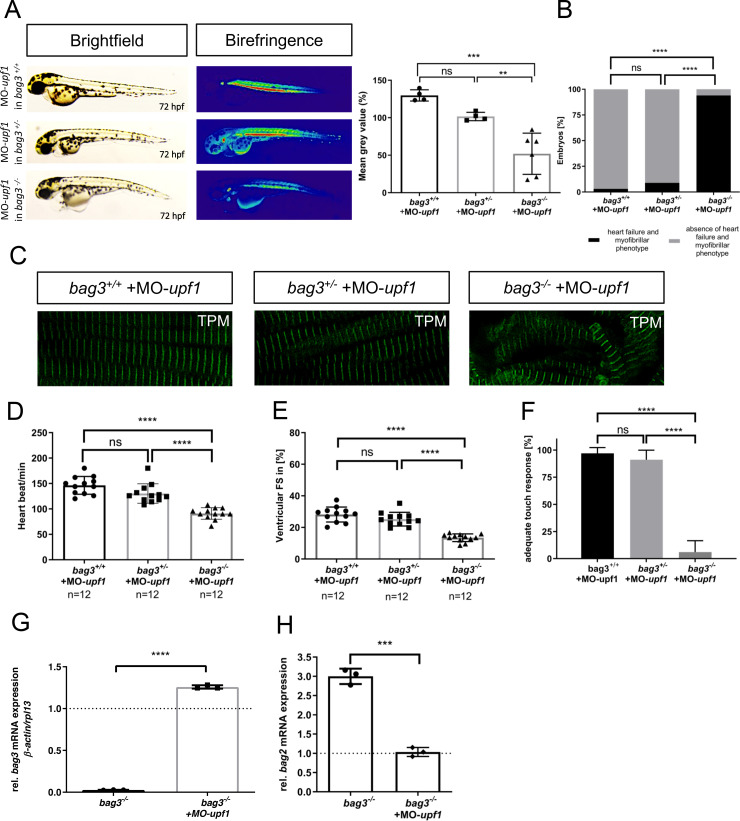
Knockdown of upf1 blocks mutant mRNA decay required for transcriptional adaptation in bag3-/- mutants.(A) Brightfield and birefringence images and densitometric analysis of birefringence (n = 4/6) of bag3+/+, bag3+/- and bag3-/- embryos at 72 hpf injected with 50μM MO-upf1. Individual samples are shown (One-way ANOVA followed by tukey's multiple comparison analysis, **P=0.0053, ***P=0.0002). (B)
bag3-/- embryos injected with MO-upf1 develop (cardio-)myopathy (93.94±10.50%), whereas bag3+/+ (96.97±5.25%) and bag3+/- (91.09±8.82%) embryos are devoid of any phenotype (N = 3, n = 40, mean ± S.D., P<0.0001, two-tailed value for Fisher´s exact test). (C) Tropomyosin immunostainings of bag3+/+, bag3+/- and bag3-/- embryos injected with MO-upf1 at 72 hpf reveal muscle fiber disruptions due to the blockage of the transcriptional adaptation only in bag3-/- injected embryos. (D) Heart rate quantification at 72 hpf reveals impairments only in bag3-/- embryos injected with MO-upf1 (N = 3, n = 12, HR bag3+/+: 146±17.49 heart beat/min; HR bag3+/-: 130±19.18 heart beat/min; HR bag3-/-: 91±11.39 heart beat/min, mean ± S.D. One-way ANOVA followed by tukey's multiple comparison analysis, P<0.0001). (E) FS of ventricles of bag3-/- embryos injected with MO-upf1 is significantly reduced at 72 hpf (FS: 13.48±2.438%) compared to the FS measured in bag3+/+ (FS: 28.17±4.753%) and bag3+/- (FS: 25.23±4.328%) morphants (N = 3, n = 12; mean± SD One-way ANOVA followed by tukey's multiple comparison analysis, P<0.0001). (F)
bag3-/- embryos injected with MO-upf1 (6.06±10.5%) reveal significant difference in responsiveness upon mechanical stimulus compared to bag3+/+(96.97±5.25%) and bag3+/- (91.09±8.82%) injected embryos (N = 3, n = 35, mean ± S.D. One-way ANOVA followed by tukey's multiple comparison analysis, P<0.0001). (G) Quantitative real-time PCR of bag3-/- +MO-upf1 and bag3-/- zebrafish embryos at 72 hpf shows restored bag3 mRNA levels only in bag3-/- embryos injected with MO-upf1 (N = 3, mean ± SD, P<0.0001 determined using two-tailed t-test). (H) Quantitative real-time PCR of bag3-/- embryos injected with MO-upf1and uninjected bag3-/- control embryos at 72 hpf reveals the downregulation of bag2 mRNA levels only in bag3-/- + MO-upf1 embryos (N = 3, mean ± SD, P = 0.0004 determined using two-tailed t-test).